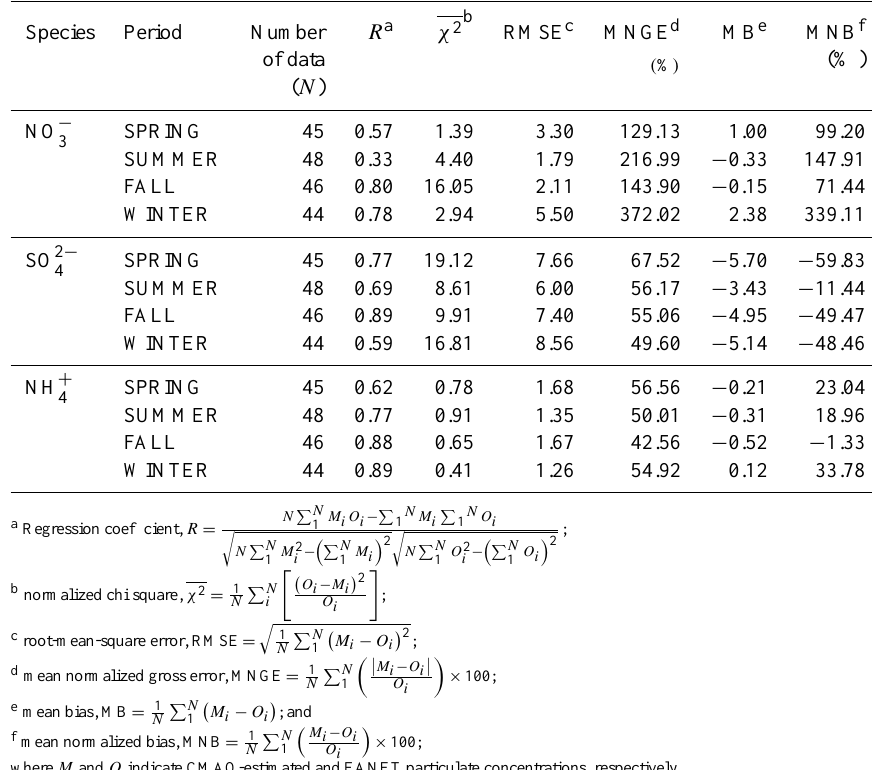
, SO 2 − , and NH + 3 4 4